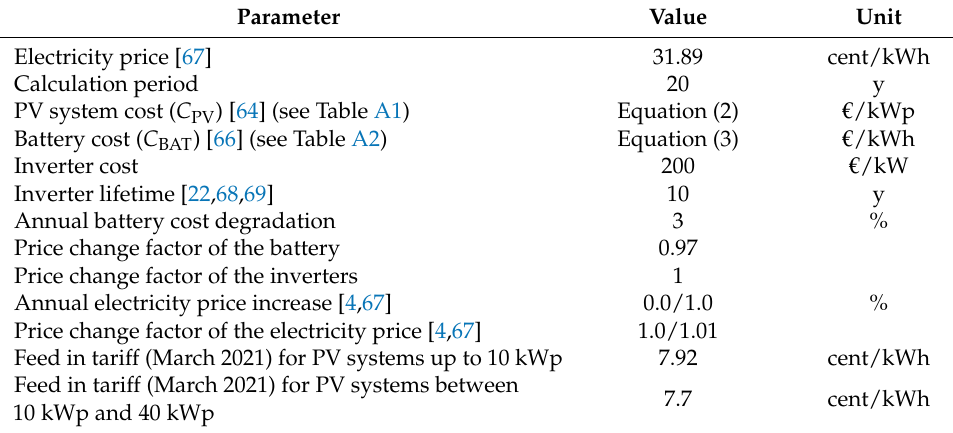
Table 3. Input data for electricity cost